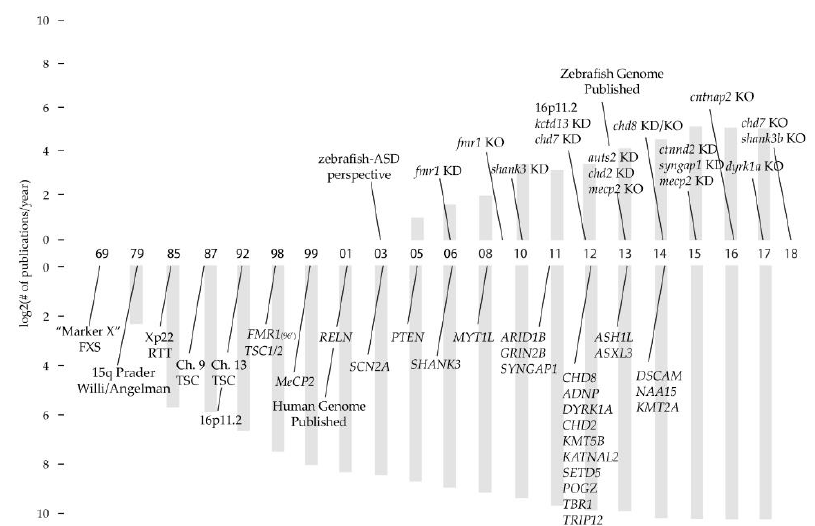
Figure 1. A timeline of ASD-ID genetic discoveries and ASD-ID modeling in zebrafish. Names represent the characterization of a gene associated with ASD-ID or the first report of a genetic variant associated with ASD-ID (bottom). ASD-ID genes where chosen from the Simons Autism Research Initiative (tier 1 genes) and common ASD-ID syndromes. Zebrafish genetic models denote the first reported embryonic or larval model and the method of genetic manipulation, KD = morpholino knock-down, KO = mutant allele. Histograms describe publications per year for PubMed keywords ASD, ID, Genes, Genetics, Loci, Chromosome (top zebrafish, bottom human). Non-linear intervals of years were averaged. Human timeline references: “Marker X” [138]; 15q Prader Wili/Angelman [139];